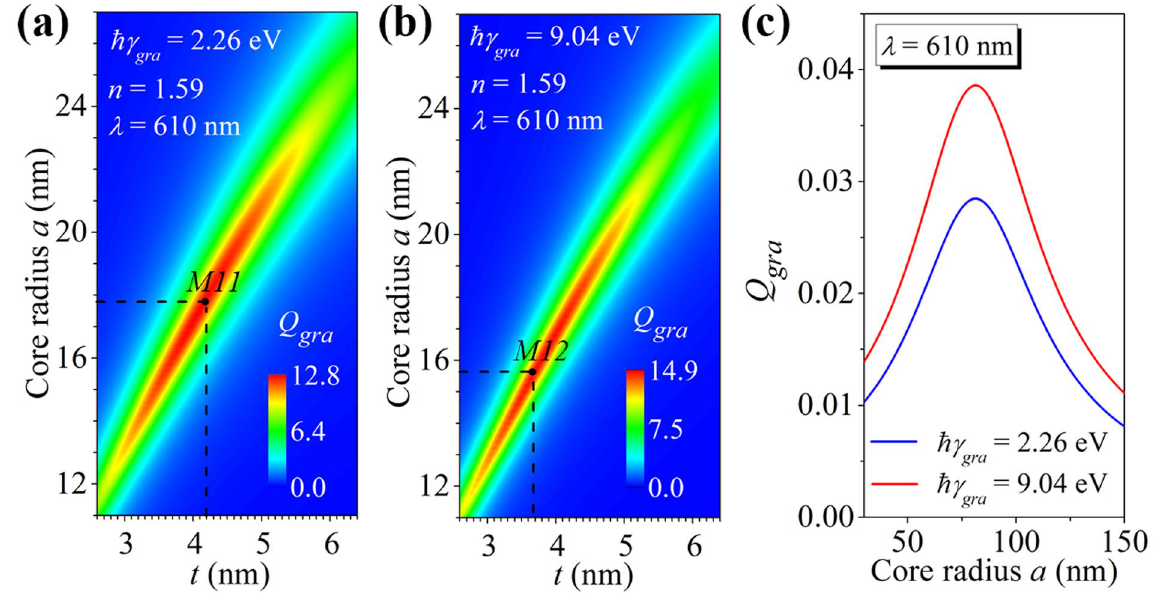
Figure 5. Graphene absorption efficiency as a function of core radius and silver shell thickness calculated at the given wavelength of λ = 610 nm for the graphene-wrapped DMCSRs with the fixed core refractive index of n = 1.59 and the graphene electron collision frequency being ħ γ gra = 2.26 eV ( a ) and ħ γ gra = 9.04 eV ( b ). Marked points M11 in ( a ) and M12 in ( b ) indicate the particular combinations of the silver shell thickness and the core radius where the graphene absorption efficiency can achieve the maximum value at the wavelength of 610 nm. ( c ) Graphene absorption efficiencies as a function of the radius of the silver nanosphere calculated at the wavelengths of λ = 610 nm and different graphene electric collision frequencies of ħ γ gra = 2.26 eV (blue line) and ħ γ gra = 9.04 eV (red line).